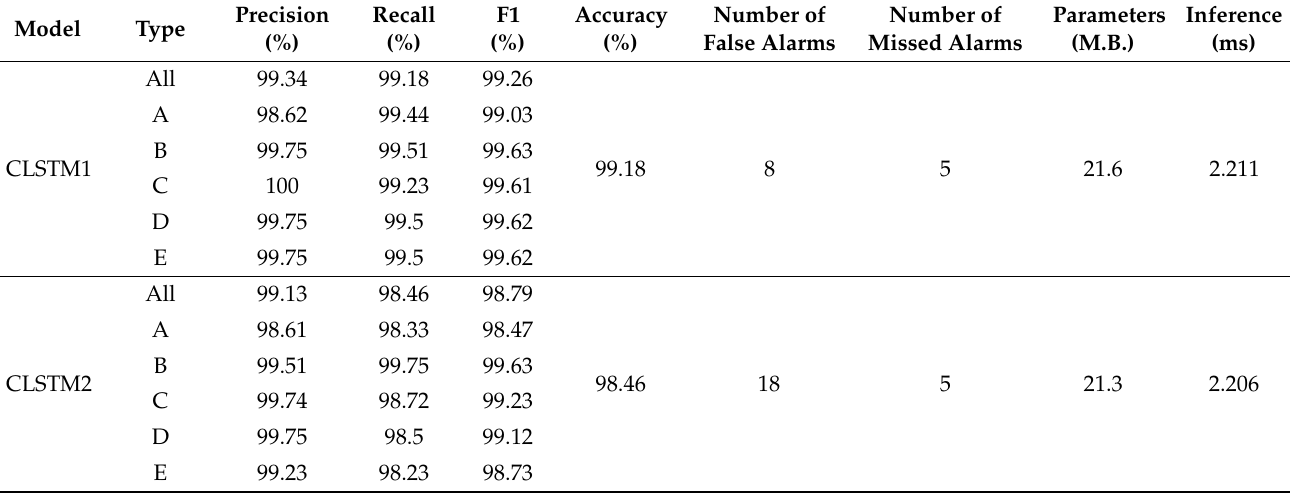
Table 3. Model performance metric